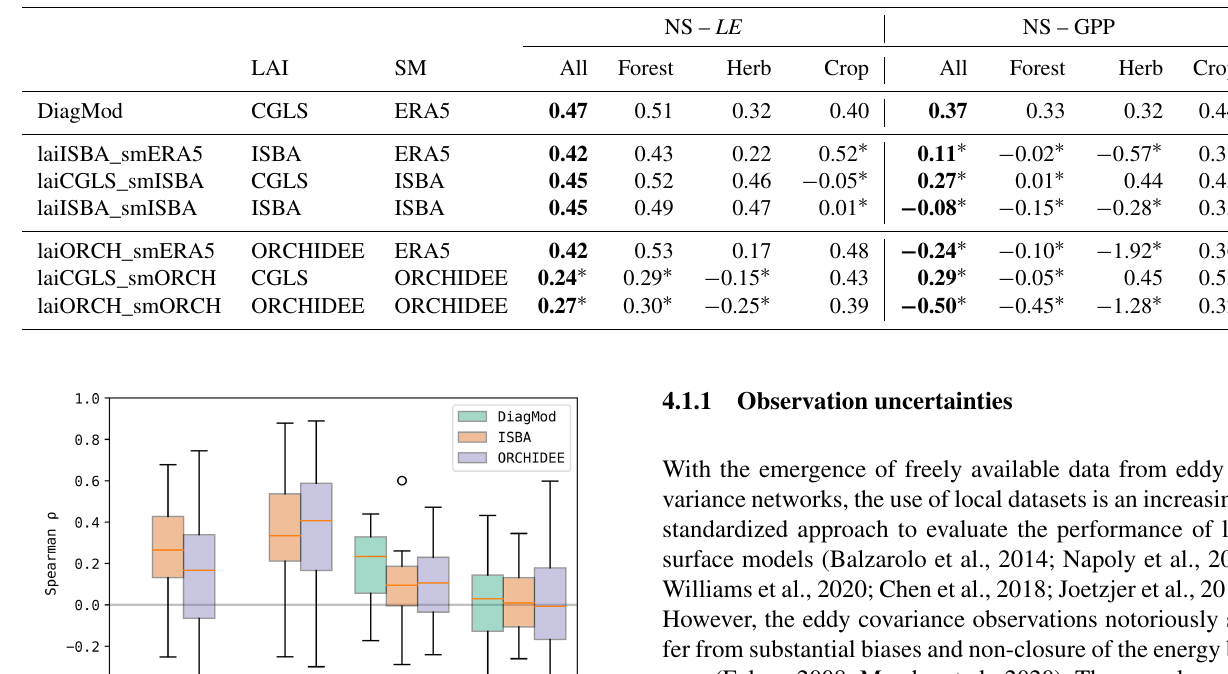
Figure 12. Boxplots of the slope of the linear regression between the anomalies in the state variables ( S e and LAI) and the fluxes ( LE and GPP) at the test sites, grouped per aridity class (1: least frequent drought stress; 4: most frequent drought stress). Table 4. Median Nash–Sutcliffe model efficiency index of the DiagMod runs (functional evaluation of the prognostic LAI and soil moisture). Results presented for all sites and classified per dominant land cover. Significant differences (Wilcoxon p < 0 . 05) with reference DiagMod runs are marked. Overall median scores are given in bold font.